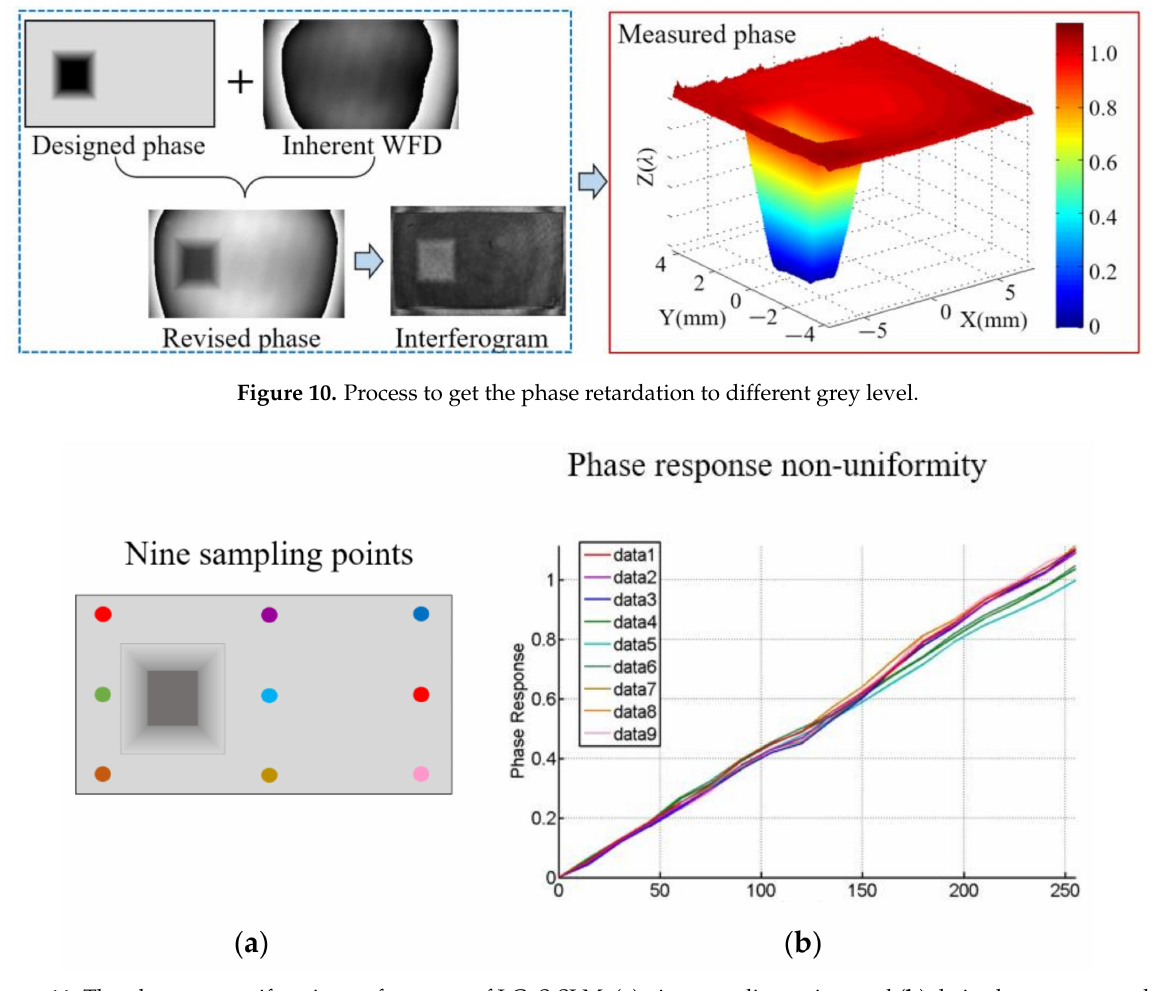
Figure 11. The phase non-uniformity performance of LCoS-SLM. ( a ) nine sampling points and ( b ) their phase response data to show the